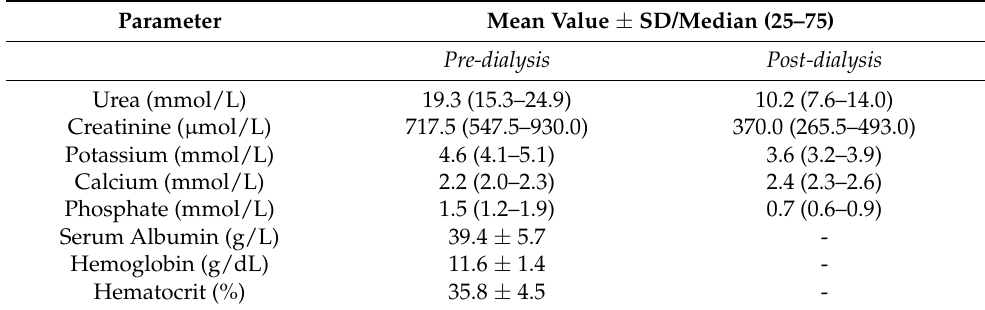
Table 3. Biological parameters (uremic control, nutrition, and anemia markers) with use of the Physidia S 3 daily home dialysis monitor. Values were described by using mean values ± standard deviation or median (percentile 25–percentile 75) according to their